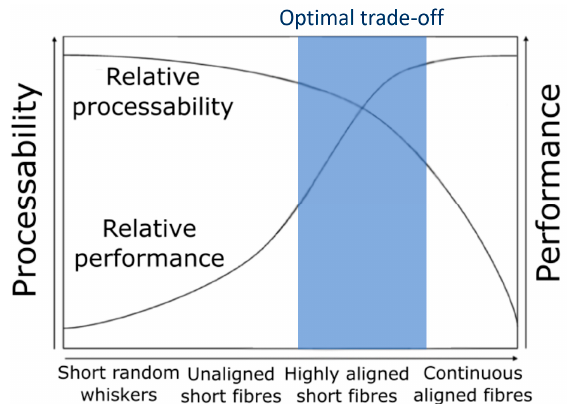
Figure 1. Balance between process ability and performance for different fibre architectures showing the optimal trade-off region, adapted from [18].